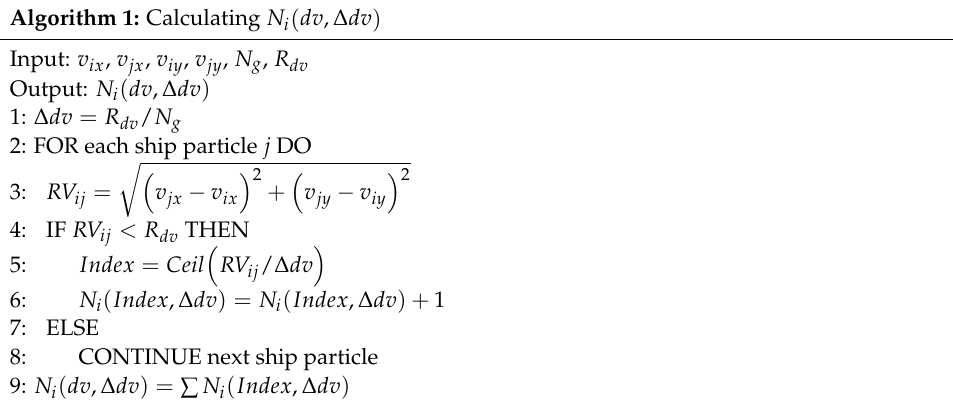
Algorithm 1: Calculating N i ( dv , ∆ dv